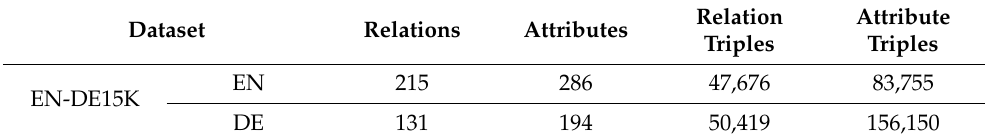
Table 2. Data statistics of the cross-lingual